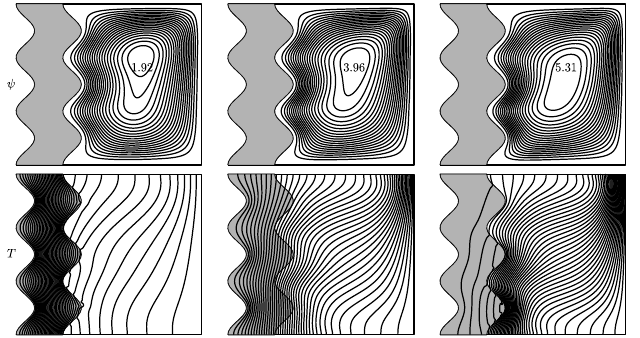
Figure 6. Variation in kr when Ra = 10 5 , Ha = 25, γ = 0 ◦ , A = 0.05, n = 3. Streamlines and isotherms at the ( top ) is for case 1, at the ( middle ) is for case 2 and the at ( bottom ) is for case 3.